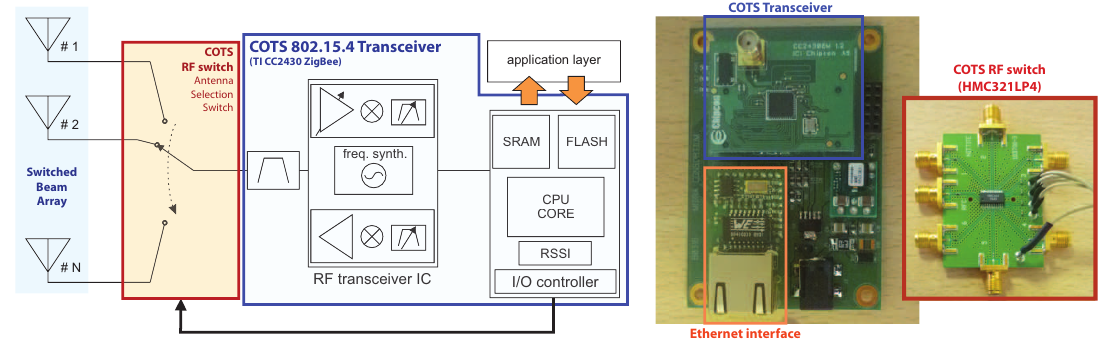
Figure 2. COTS IEEE 802.15.4 anchor node hardware